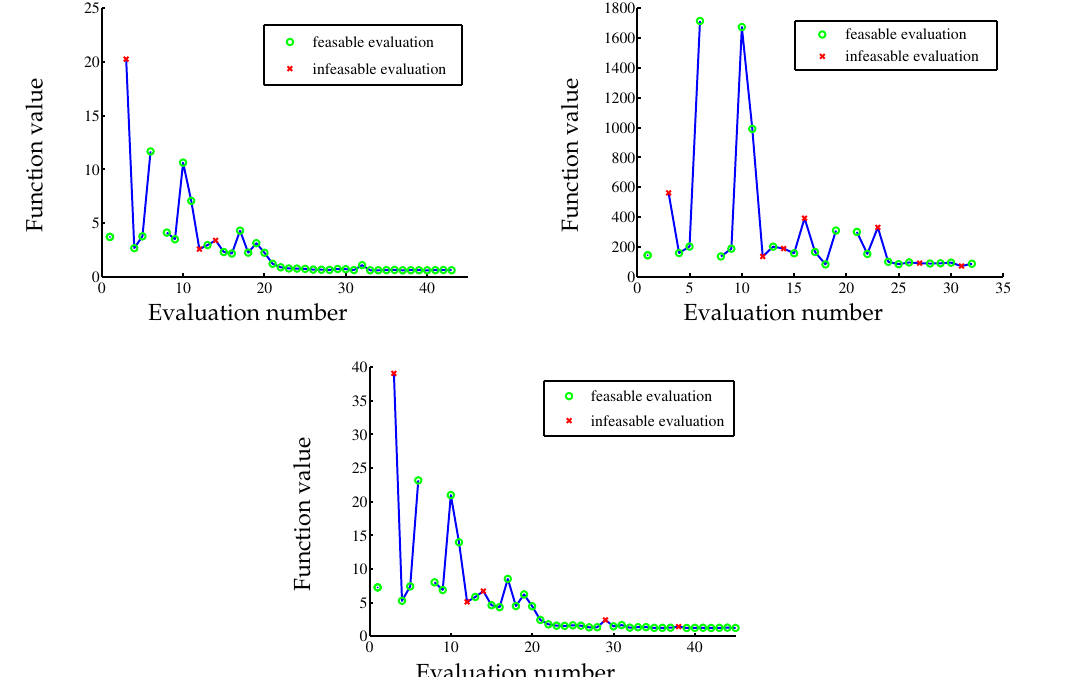
Figure 7. Evaluation history for uniform weights, binary weights, and mixed weights. Initial values are 3.7283, 145.45821 and 7.2703; optimised values are 0.6219, 84.3588 and 1.2397, respectively.